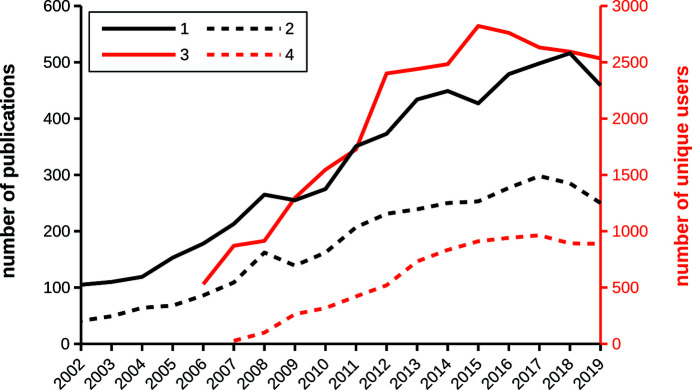
The number of biological SAS publications per year (1) has steadily increased over the past two decades, accompanied by an increase in the number of biological SAS publications which cite the ATSAS software suite (2). The numbers of unique users per year that downloaded ATSAS (3) and used the web applications in ATSAS online (4) also show a concurrent increase.